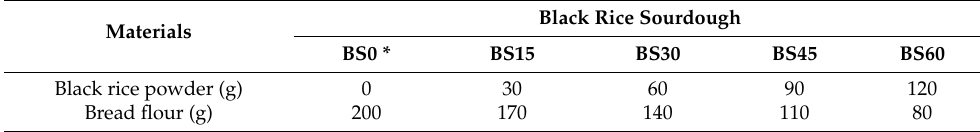
Table 1. Formula of black rice